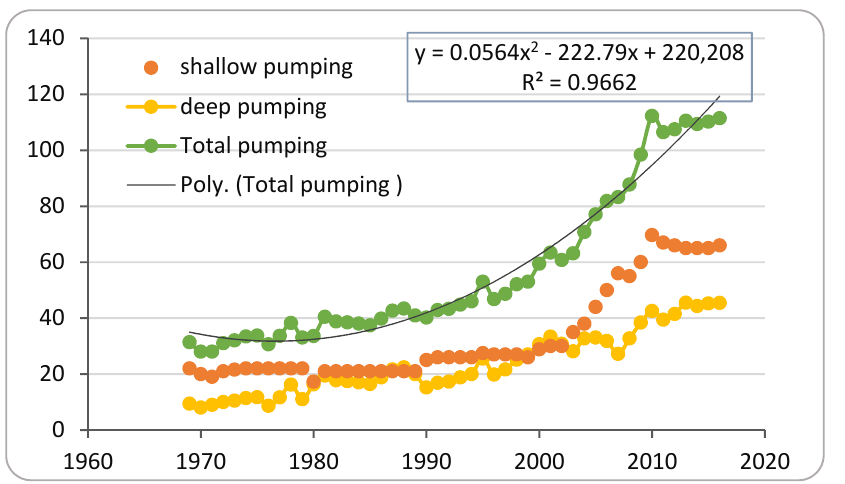
Figure 3. Pumping volume (Mm 3 ) of Mio-Plio-Quaternary aquifer from 1970 to 2016 (Official data from DGRE).